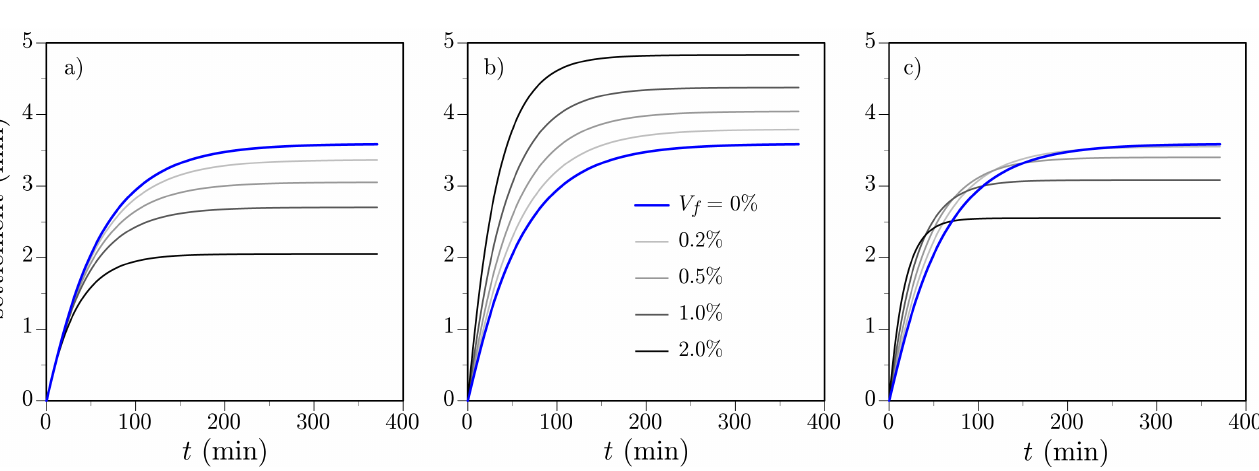
Figure 15. Influence of fiber dosage on surface layer settlement considering: ( a ) stiffness contributions of fibers; ( b ) conduc- tivity contributions of fibers; and ( c ) combined stiffness and conductivity effects of fibers.